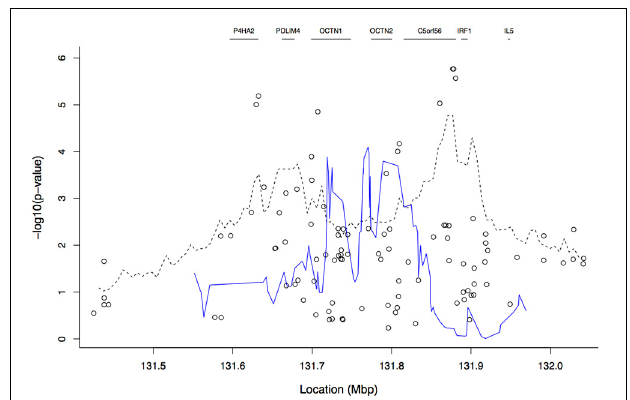
FIGURE 4 | Plot of − log 10 of the p -values from the TDTHAP analysis using a window size of 20 SNPs (blue solid line). The open circles and the dashed line give the single-SNP and tree-based results, respectively, that were also shown in Figure 3 . Gene boundaries are marked by horizontal line segments at the top of the plot.